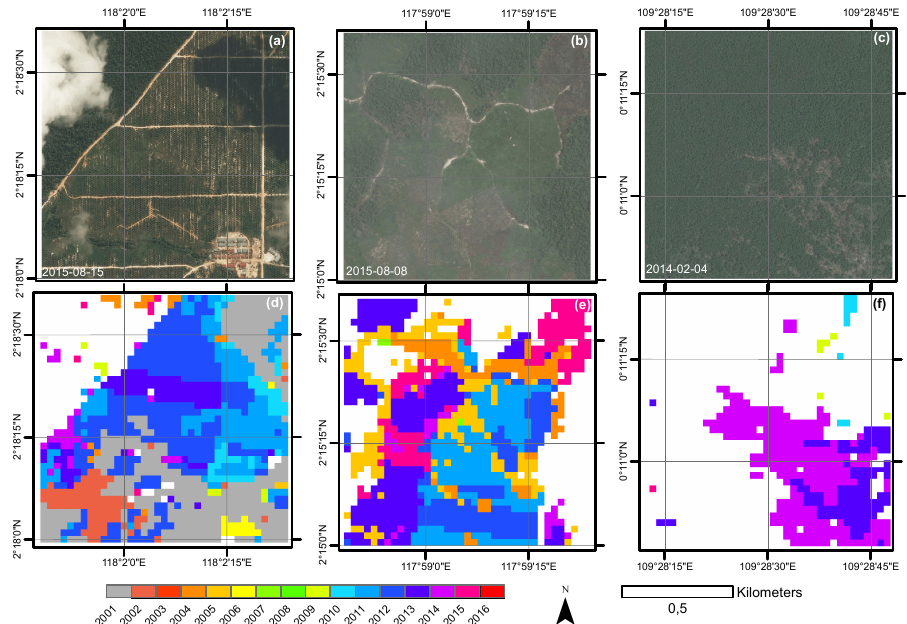
Figure 8. Wall-to-wall application of the proposed deforestation detection algorithm with optimal (i.e., highest spatial accuracy) cons = 3 and k = 4 to three VHSR scenes. History noise removal was not applied. The bottom row ( d – f ) shows the year (aggregated from deforestation date, for visualization purpose) of deforestation event detected by the algorithm. The top row ( a – c ) shows the corresponding VHSR image evidence of the latest available date. Areas in white were not detected as having deforested. The years are shown starting from 2001 as the monitoring was started from 2000. The dates of VHSR images were shown at lower left corner. The VHSR images were obtained through Digital Globe viewing